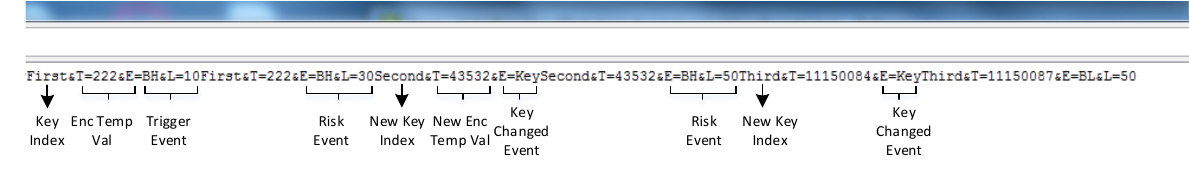
Figure 16. Scenario 2: sensor screen: encryption adapts to increased key lengths when the battery is recharged to a threshold level.